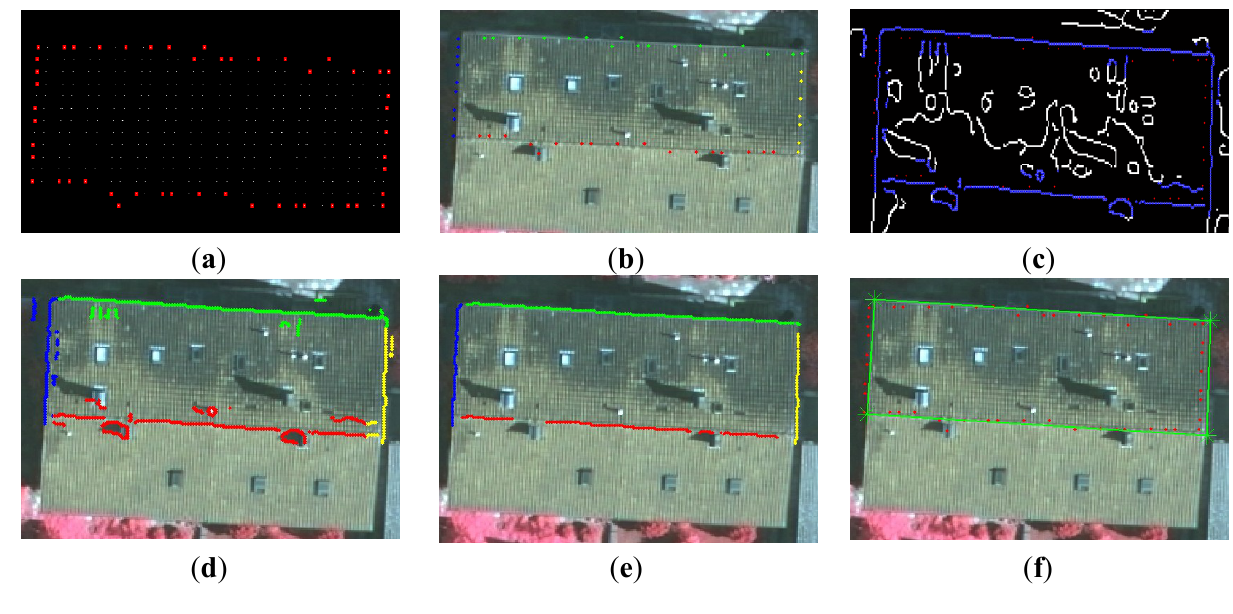
Figure 11. Process of real corner extraction from aerial image. ( a ) 3D boundary points of one rooftop plane(red); ( b ) the grouped 3D boundary points were back projected to the corresponding image (different color indicates different group); ( c ) 2D edge pixels (blue) in the buffer of the back projected boundary points; ( d ) the grouped 2D edge pixels; ( e ) inliers of RANSAC were projected to the image (different color indicates different group); ( f ) the extracted 2D corners (green